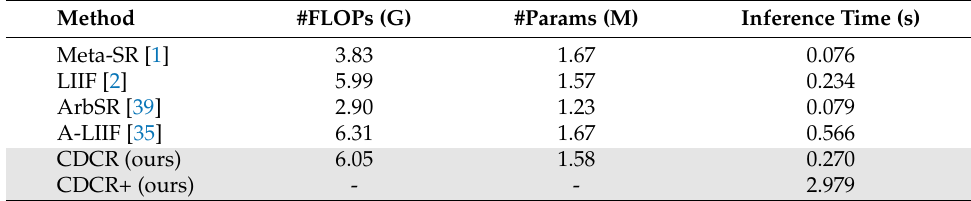
Table 6. The statistics of FLOPs, Params, and Inference Time for different methods. #FLOPs (G) indicates the computation amount for a single image during the inference phase. #Params (M) indicates the number of model parameters, and Inference Time (s) indicates the average time taken to infer an